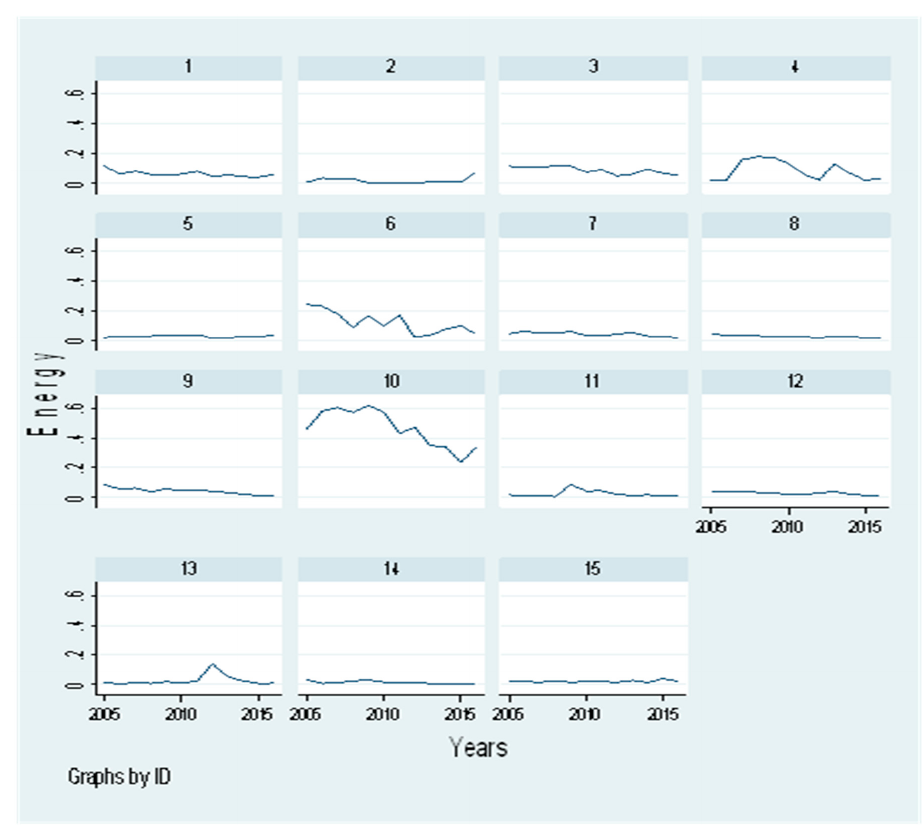
Figure 2. Energy use trends by industry groups.